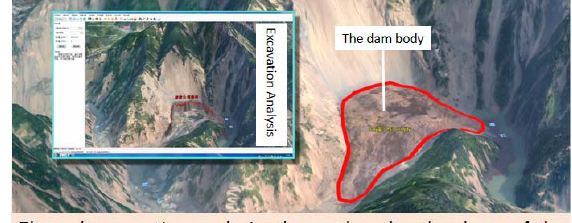
Figure 4. Excavation Analysis (Technology Innovation Center of Emergency Surveying and Mapping, 2008)